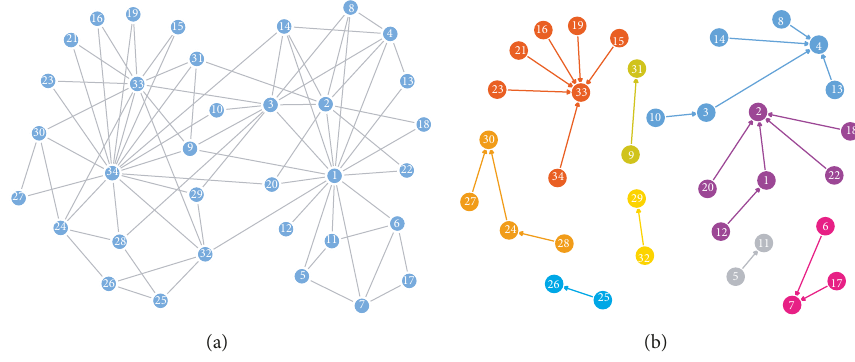
Figure 1: The procedure of FPC() on the karate club